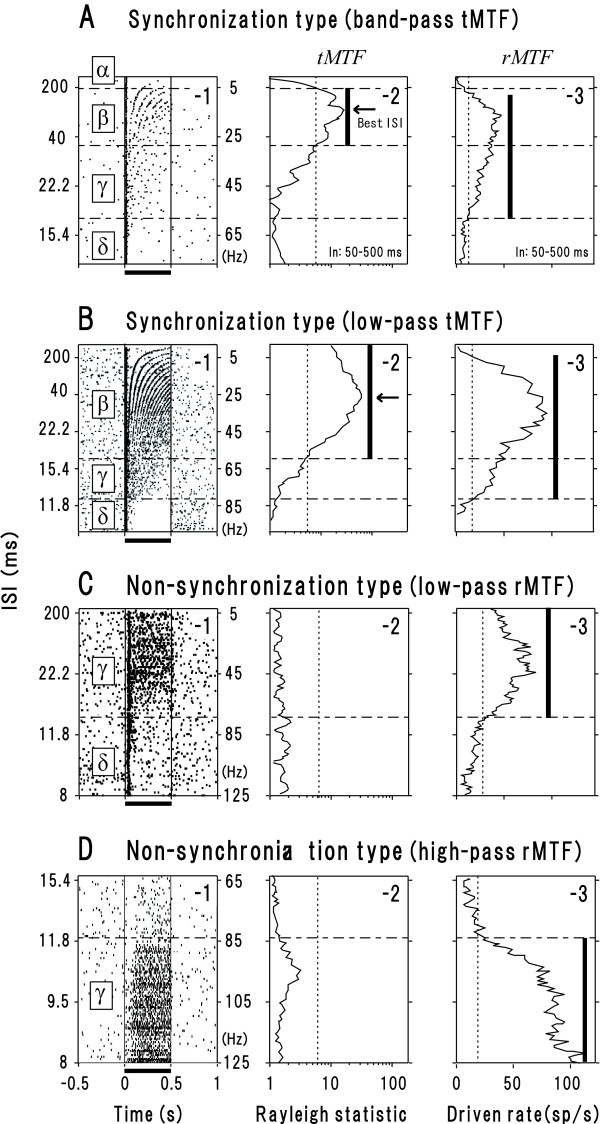
Response profiles for 4 representative neurons (A, B: synchronization type; C, D: non-synchronization type) in the click-train paradigm. (1st column) Raster display of spike occurrence in response to 0.5-s-long click trains (horizontal bar) at variable inter-stimulus intervals (ISI; ordinate, left) or repetition rate (ordinate, right). Regions α-δ represent qualitatively distinct response patterns as defined below. (2nd column) The "temporal modulation transfer function (tMTF)," defined as Rayleigh values as a function of ISI. The vertical bar denotes the ISI range of "region β" where statistically-significant degree of stimulus-locking responses took place (P < 0.05, Rayleigh statistics). The ISI that gives the maximal Rayleigh value is denoted as the "best ISI" (arrow). In majority of the synchronization neurons, the longer-ISI limit of region β (upper margin) was bordered with "region α" (A-1) where only the onset response was evident. (3rd column) The "rate modulation transfer function (rMTF)," defined as the mean driven rate (over 50–500 ms after the initiation of the train) as a function of ISI. The vertical bar denotes the ISI range where the mean driven rate exceeded the threshold for excitation (2*SD of spontaneous firing rate; dotted line). Among the ISI range, the one where no stimulus-locking responses took place was denominated as "region γ." In majority of the neurons examined, the shorter-ISI limit (lower margin) of region γ was bordered with "region δ" where only the onset response was evident. See text for details.